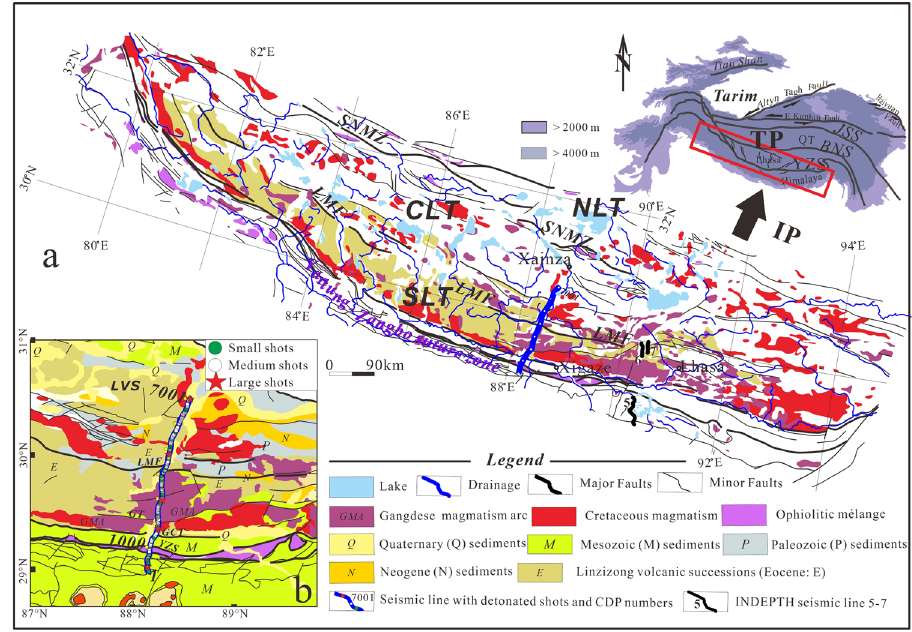
Fig. 1 Geological map and research area. a Simpli fi ed geological map of the Lhasa terrane, southern Tibet (After China Geological Survey 48 ). Numbered bold lines (5 – 7) indicate the INDEPTH seismic pro fi les that were deployed on both sides of the YZS; ( b ): zoomed-in map showing more details of surface geology of the research area. The inset shows the location of the research area (red box) in a larger context. Blue solid lines represent the location of seismic arrays with distribution of detonated shots and CDP numbers. TP the Tibetan Plateau, IP the Indian Plate, BNS Bangong-Nujiang suture zone, JSS Jinsha suture zone, NLT northern Lhasa terrane, CLT central Lhasa terrane, SLT southern Lhasa Terrane, SNMZ Shiquanhe-Namco mélange zone, LMF Luobadui-Milashan Fault, GCT Great Counter Thrust; GT Gangdese thrust, YZS Yarlung-Zangbo suture, LVS Linzizong volcanic succession, GMA Gangdese Magmatic Arc, See legend for more information of abbreviations (same abbreviations